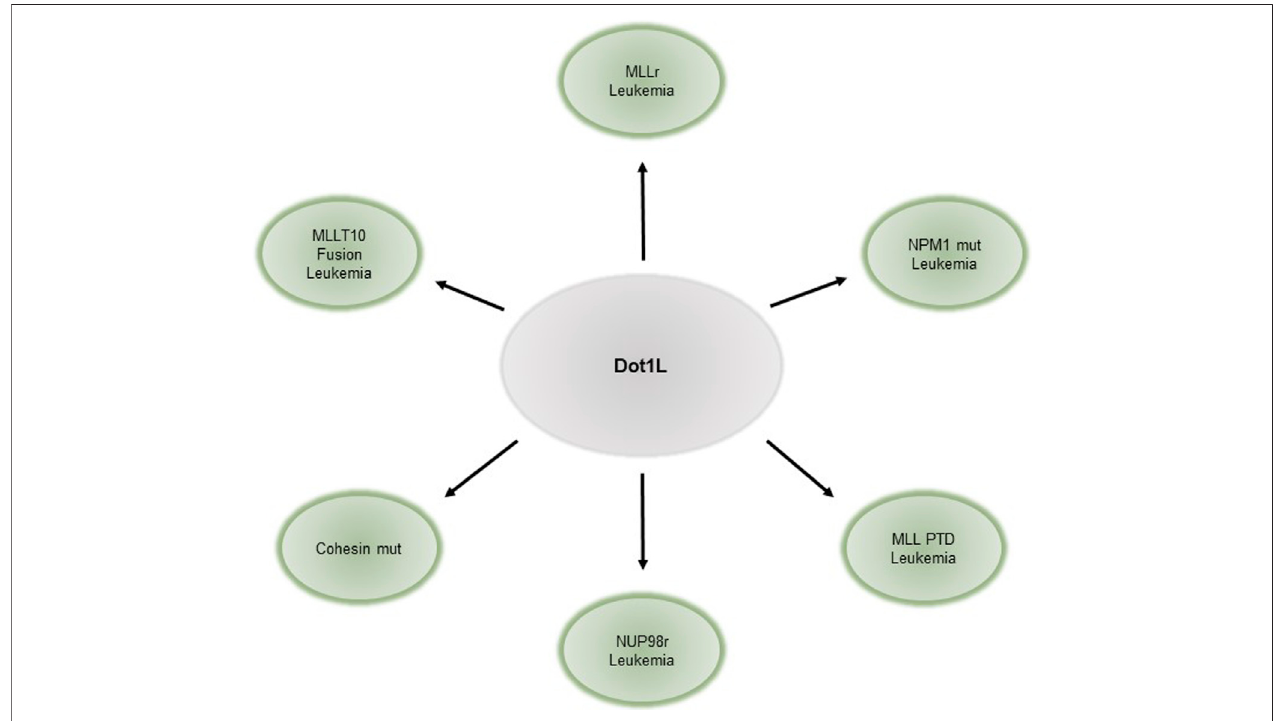
FIGURE 1 | Requirement of DOT1L in hematopoietic malignancies.